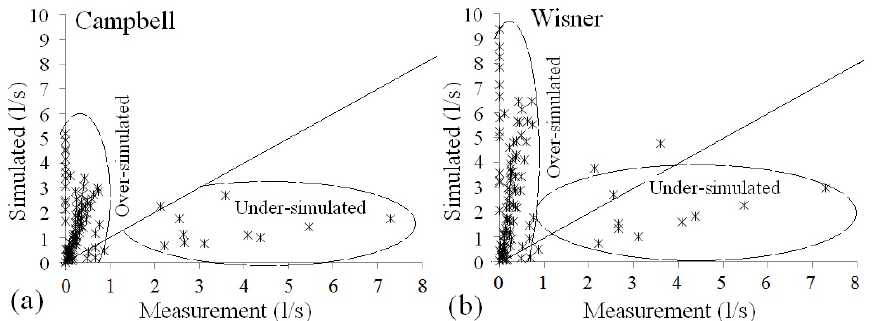
Figure 5. Comparing the results of Campbell and Kalinske-Robertson’s empirical models versus the observations (1st fold).